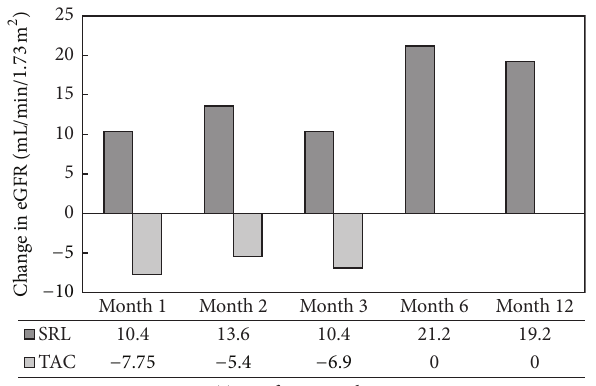
Figure 3: Change in eGFR over 1-year follow-up after transplant from the date of maintenance immunosuppression initiation ( 𝑃 < 0.05 at all time